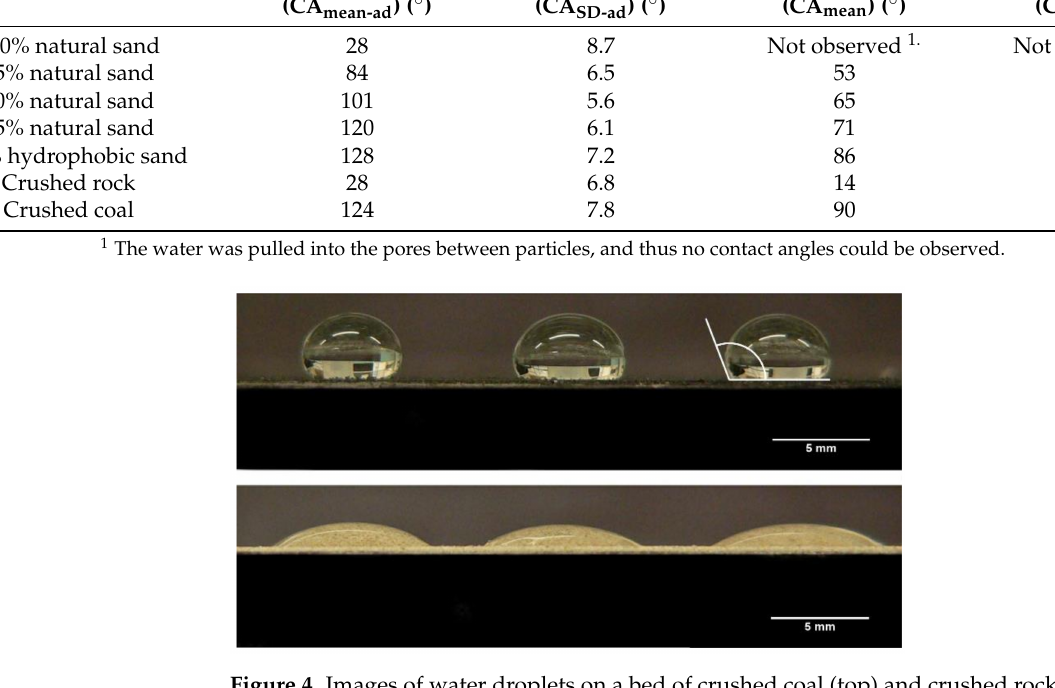
Figure 4. Images of water droplets on a bed of crushed coal (top) and crushed rock (bottom). Both images show droplets used to measure the advancing contact angles, and the top right droplet indicates the angle